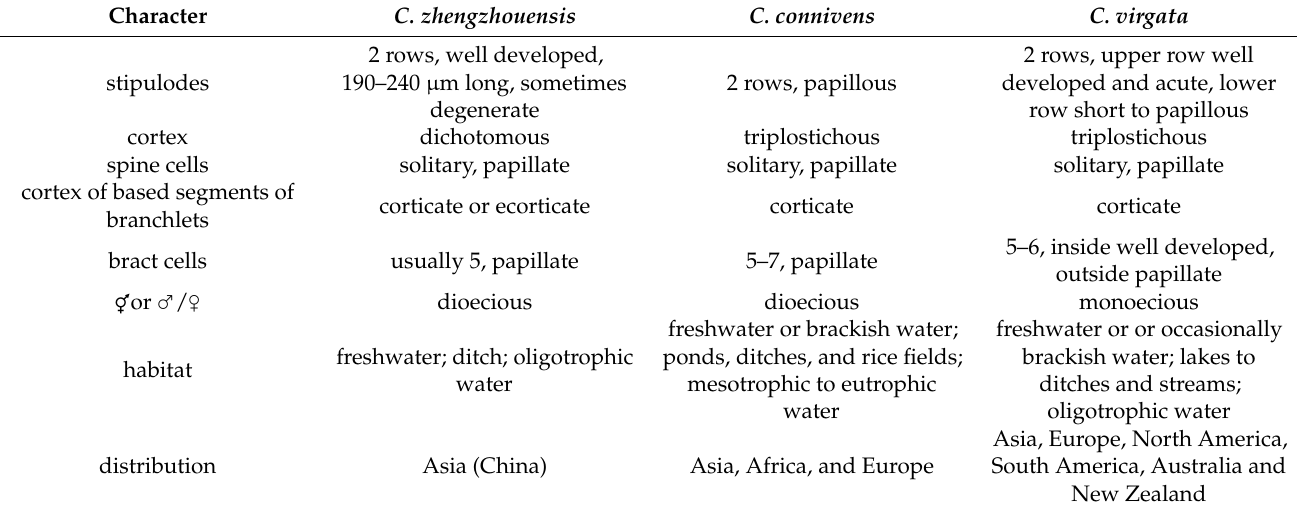
Table 4. Morphological comparisons of Chara zhengzhouensis with two other similar